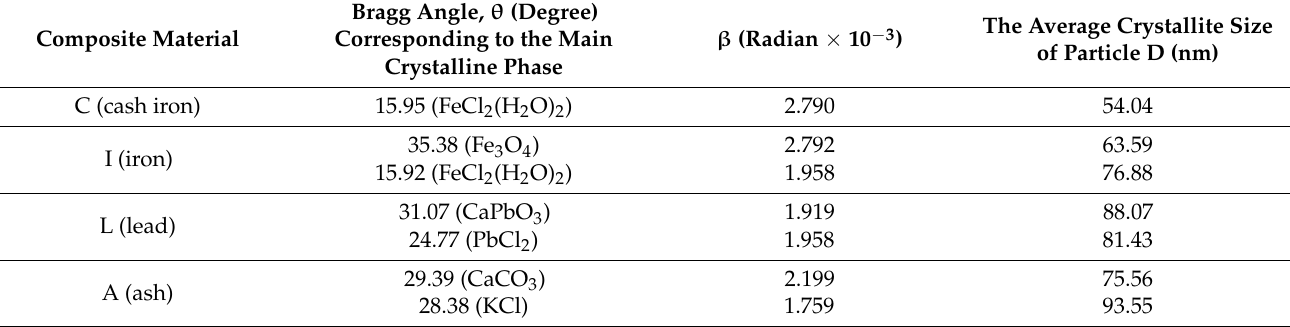
Table 2. Average size of particle D of the high intensity peak of prepared composites.